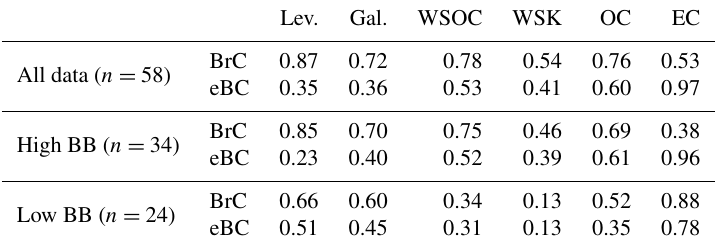
Table 3. Spearman correlation between optical measurements of carbonaceous aerosol brown carbon (BrC) and black carbon (eBC) as well as the selected smoke tracers levoglucosan (Lev.), galactosan (Gal.), WSOC, WSK, OC, and EC measured at the Monserrate site. Correlation coefficients are shown for all data, as well as for the low and high BB seasons; N represents the number of samples. Lev. Gal. WSOC WSK OC EC BrC All data ( n = 58)